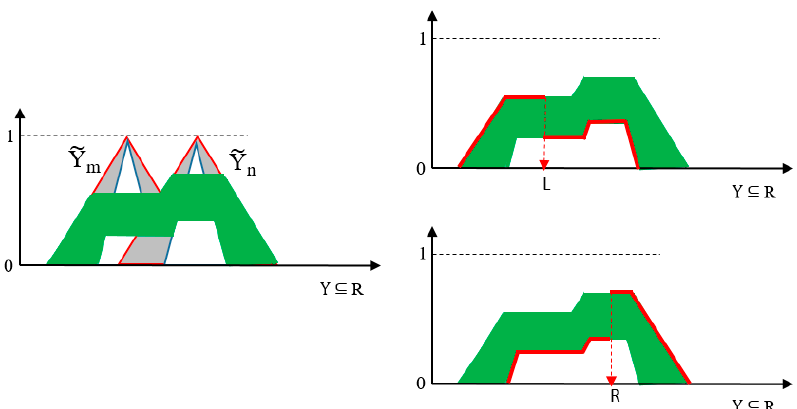
Figure 4. Combined FOU for two sample rules with two interval type-2 (IT2) sets in the conclusions. The final system output is defined as (y l + y r )/2, where y l and y r are calculated with respect to L and R values, which can be determined using the Karnik–Mendel algorithm.